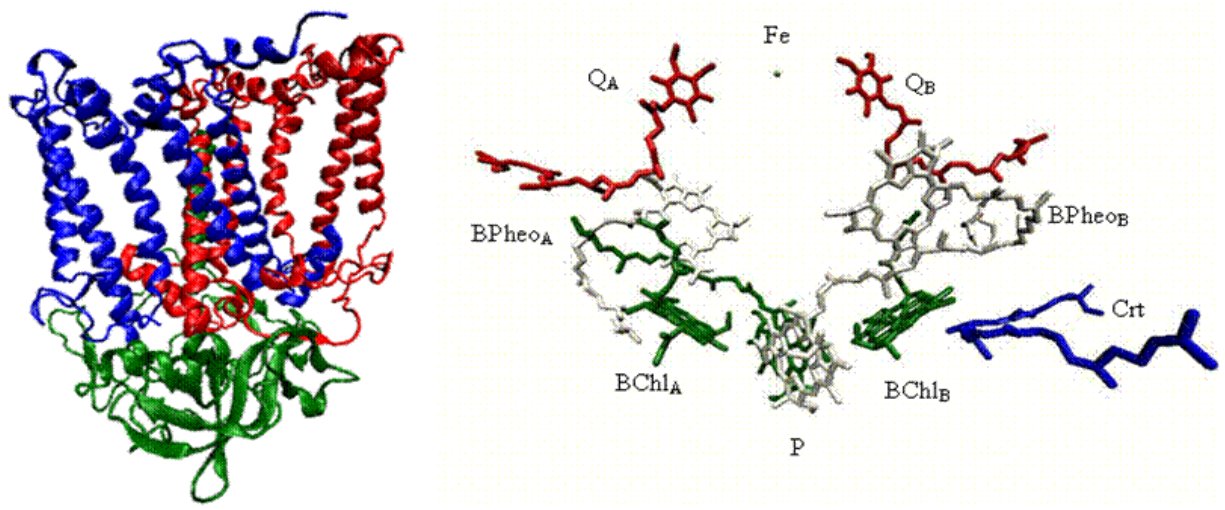
Fig. 3. The molecular model of photosynthetic reaction centre of Rb. sphaeroides calculated from data of crystal structure down- loaded from the Brookhawen Protein Data Bank (www.rcsb.org, code name: 1pst). Picture was drawn by VMD program. Left: the protein frame with three subunits (H-green, L-blue and M-red, as indicated). Right: redox acive cofactors carrying the electron transfer. P: primary donor bacteriochlorophyll dimer. BChl: monomer bacteriochlorophylls. BPheo: bakteriopheophytine. Q Q are the primary and secondary quinone type electron acceptors, B